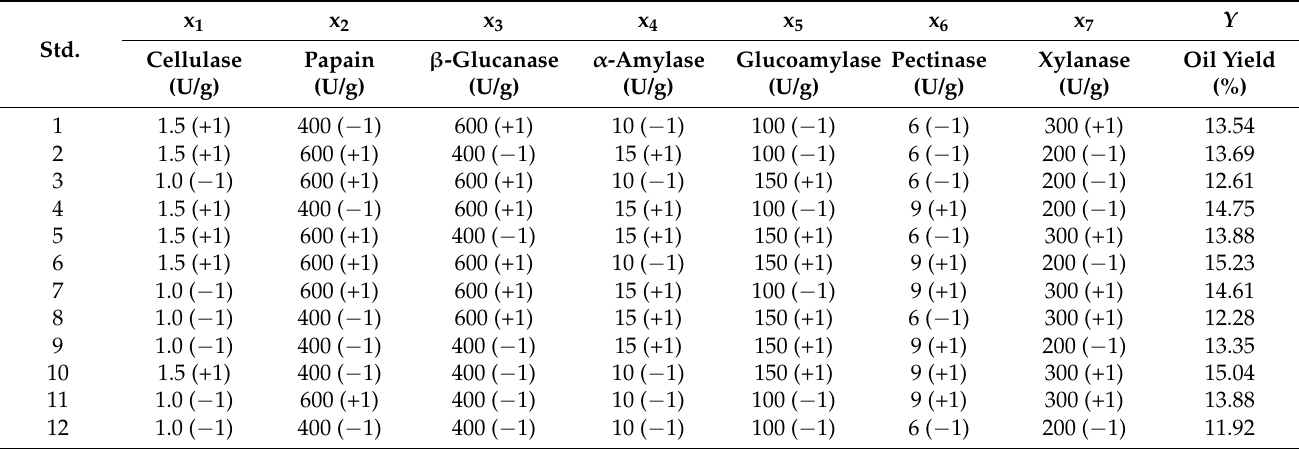
Table 1. Plackett–Burman design (PBD) for screening key enzyme components affecting peony seed oil yield from enzymatic extraction.